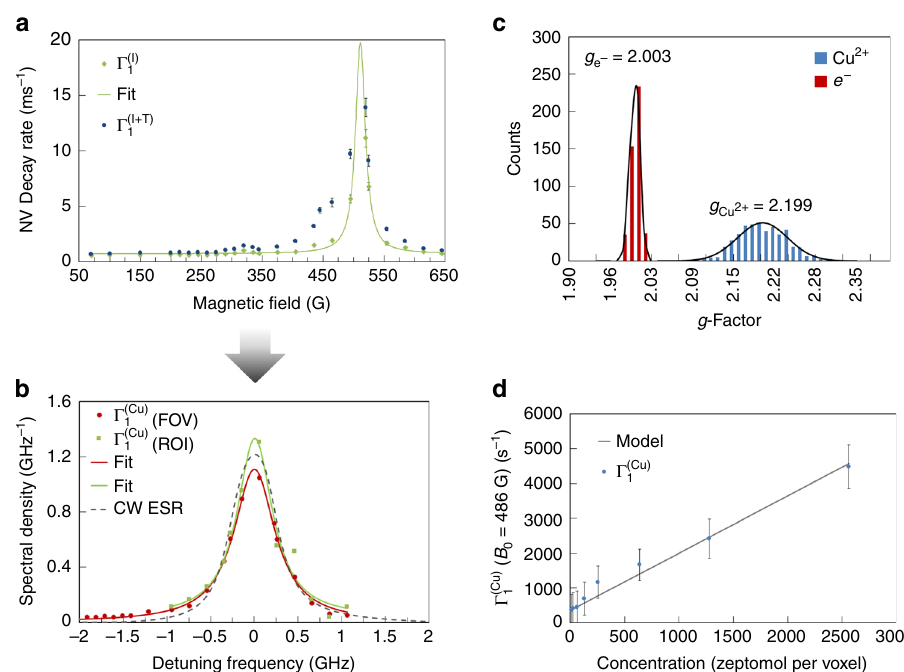
Fig. 3 High-resolution electronic paramagnetic resonance imaging and spectroscopy. a T 1 decay rate as a function of applied magnetic fi eld B 0 for 1 mM of nitric acid, (intrinsic- green diamonds ) and 100 mM of Cu 2+ ions, (intrinsic+ target- blue circles ). The uncertainty in the relaxation is given by the rms error on (cid:2) Γ I ð Þ the T 1 stretched exponential fi t. b Relaxation rate spectra, Γ Cu ð Þ , identi fi ed by subtracting Γ I þ T ð Þ from the fi eld of view ( FOV ) (35 × 35 µ m 2 ) and region 1 1 1 of interest ( ROI ) (1.6 × 1.6 µ m 2 ). The absorption peak at 486 ± 1 G corresponds to a g -factor of 2.21 ± 0.02, consistent with the effective g -factor for aqueous Cu 2+ ions from conventional CW EPR, see dashed grey line . c Histogram of the measured g -factor from each imaging voxel for Cu 2+ ions and free electrons. The distribution of g -factors for the free electrons is centred at g = 2.003 with a standard deviation of 0.007, while the Cu 2+ distribution exhibits , on resonance ( B 0 = 486 G) vs. Cu 2+ concentration. a distribution centred at g = 2.199 with a standard deviation of 0.03. d Measured relaxation rate, Γ Cu ð Þ 1 The error bars are given by the rms error on the T 1 stretched exponential fi t. The minimum detectable number of spins in a sensing volume de fi ned by 0.025 µ m 3 or (25 aL) is ~ 75,000 spins per voxel or ~ 125 zmol per